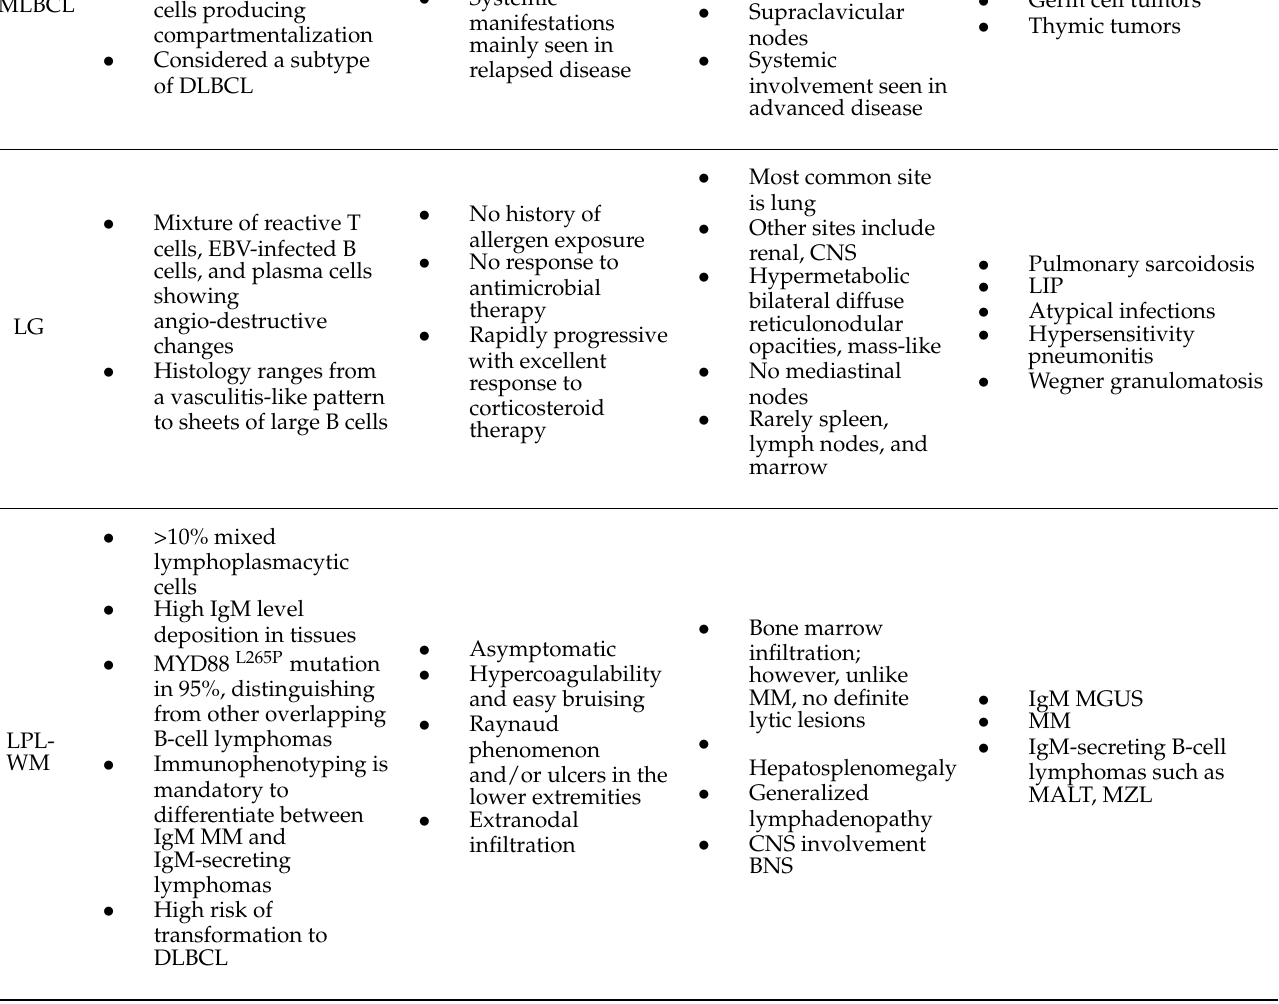
Abbreviations listed in Table 2: Lymphomatosis cerebri (LC), Non-Hodgkin’s lymphoma (NHL), B-Cell lymphoma (BCL), T-cell lymphoma (TCL), Diffuse large B-cell lymphoma (DBCL), Corticospinal tracts (CST), Primary mediastinal large B-cell lymphoma (PMLBCL),